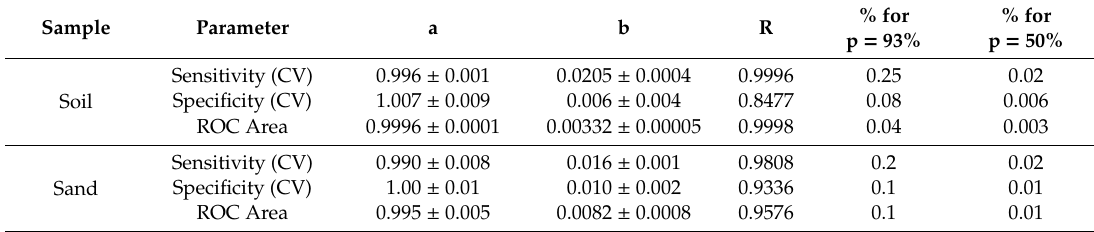
Table 2. PLS-DA parameters for the fits for 93% and 50% probabilities for petroleum sensing.